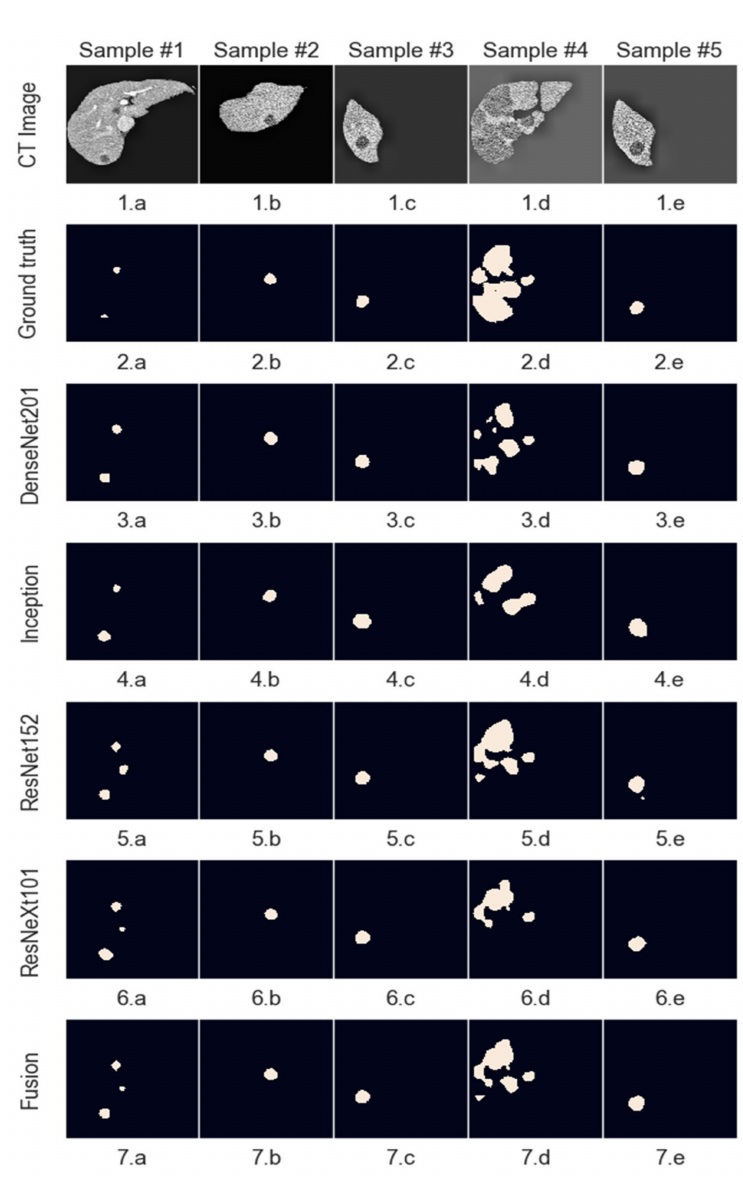
Figure 12. Sample lesion